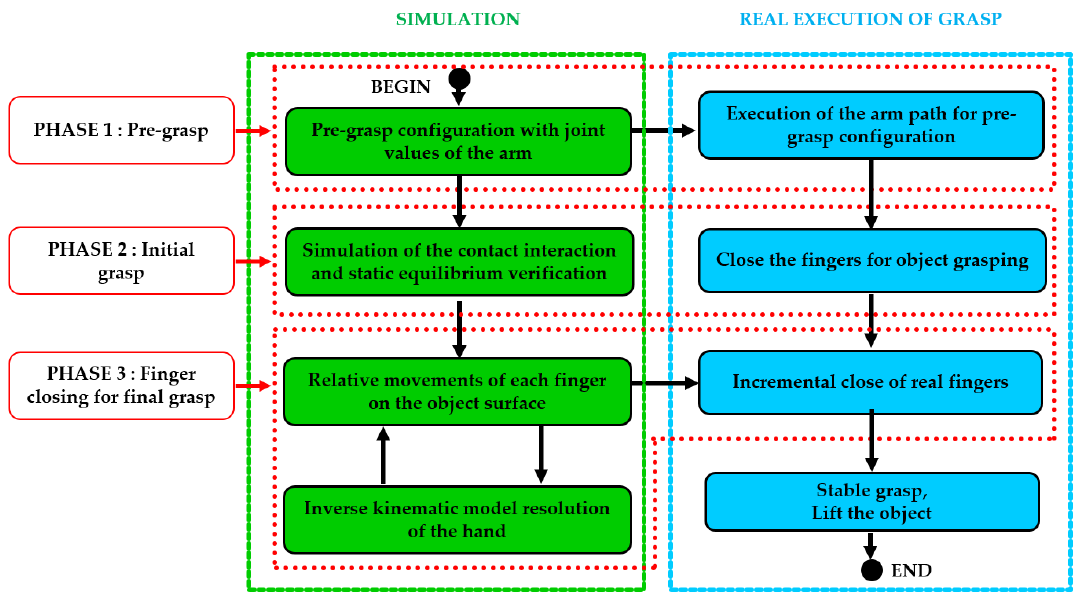
Figure 1. Flowchart of the proposed grasp planning pipeline (i.e., pregrasp and grasping strategies) for handling deformable objects with a hand + arm robot